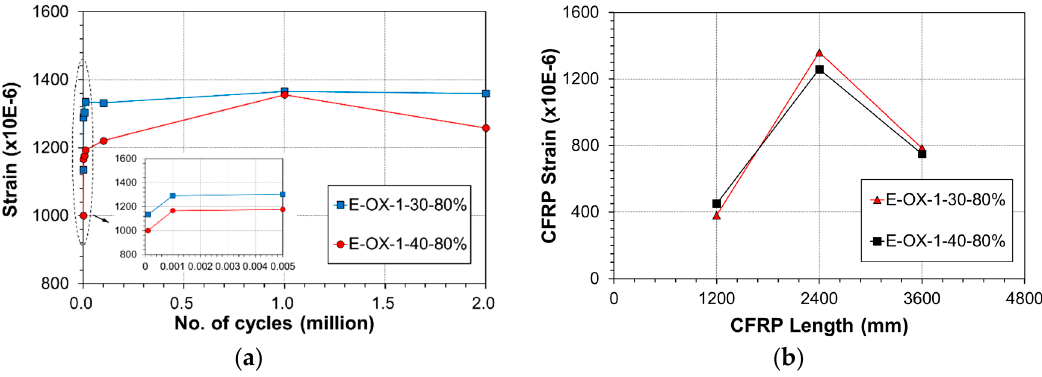
Figure 7. Variation of CFRP strain during fatigue loading at upper load limit: ( a ) mid span; ( b ) location.